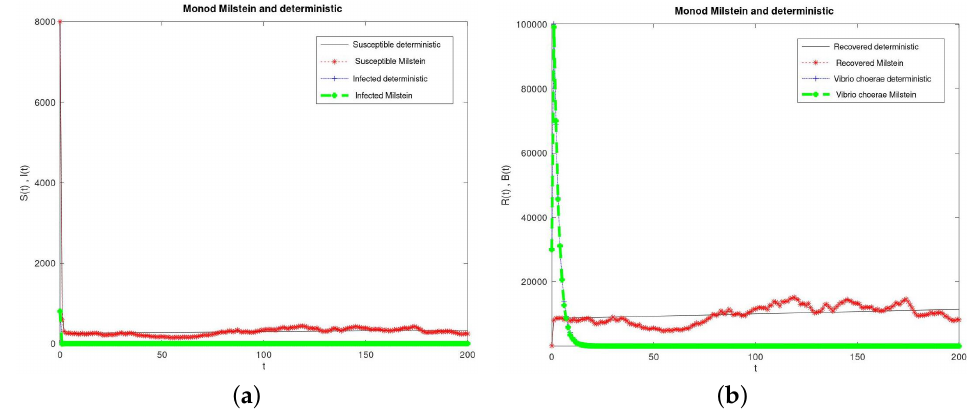
Figure 8. Simulation showing the dynamic behavior of susceptible humans, infected humans, recov- ered humans, and the Vibrio cholerae population and is given for A = 15; β 1 = 0.2143; β 2 = 0.000002. ( a ) revealed that the susceptible population decreases over time while the stochastic simulation are very close to the simulation results of the deterministic model. ( b ) also revealed that the vibrio cholerae population decreases over time while the population of the recovered human increases over time and their stochastic simulation are very close to the simulation results of the deterministic model.; d = 0.015; δ = 0.33; ζ = 100; α = 0.025; µ = 0.0000548; r = 0.004; σ = 0.05; K = 10 9 ; u 1 = 0.9;